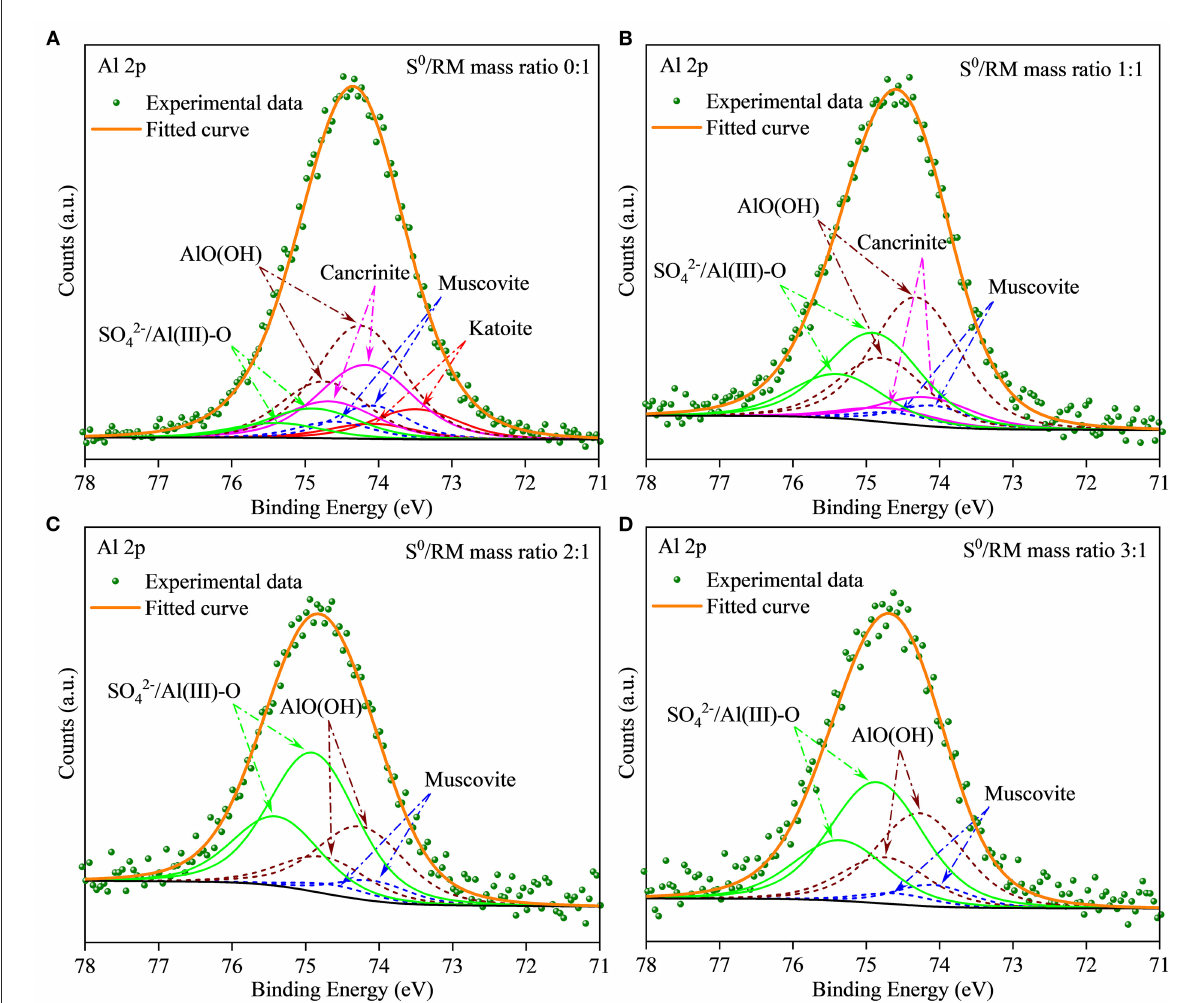
FIGURE6 XPS spectra of Al in solid RM residues after bioleaching by Sb. thermosulfidooxidans . Bioleaching was conducted for 27 days in shake flasks with the S 0 /RM mass ratio of (A) 0:1, (B) 1:1, (C) 2:1, and (D)